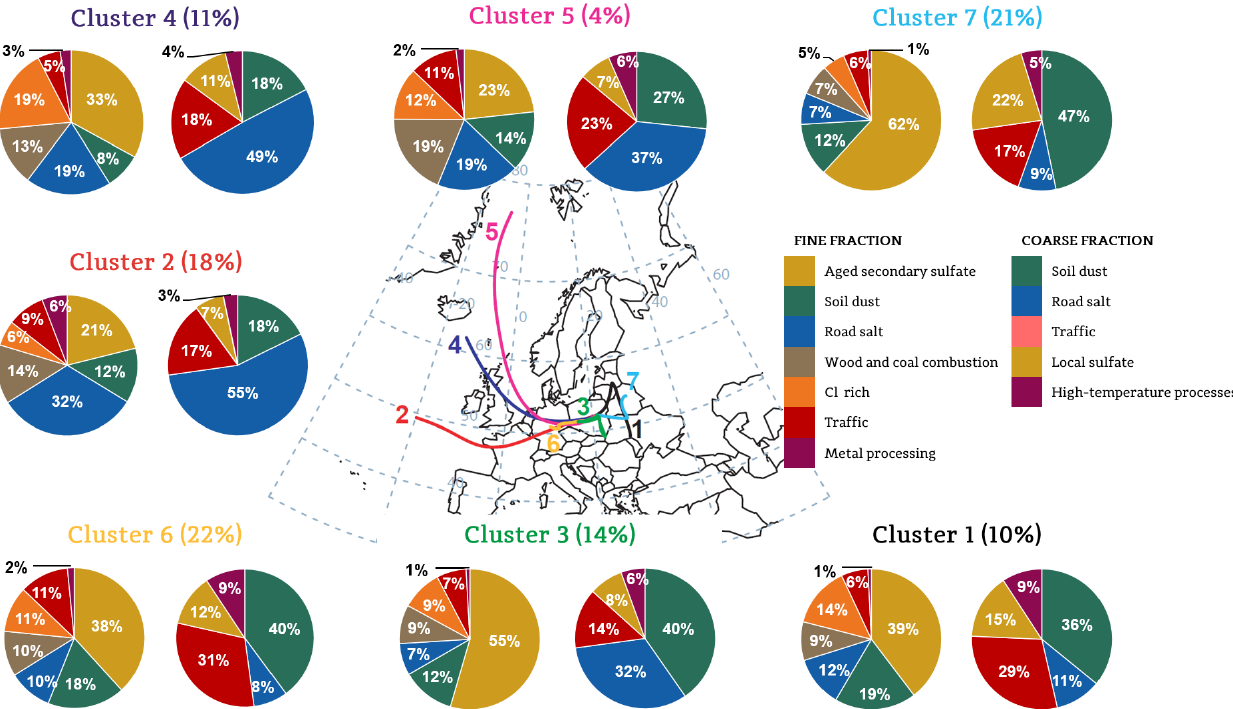
Figure 7. Trajectory cluster centroids arriving to Warsaw at 200m (center map), with the PMF factor contribution in different clusters for the fine (left pie charts) and coarse (right pie charts) fraction. The percentage of the trajectories classified into each cluster is given in